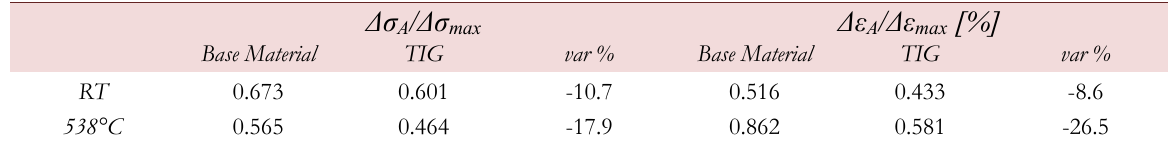
Table 6: Fatigue strength at N ref cycles of base material and TIG.